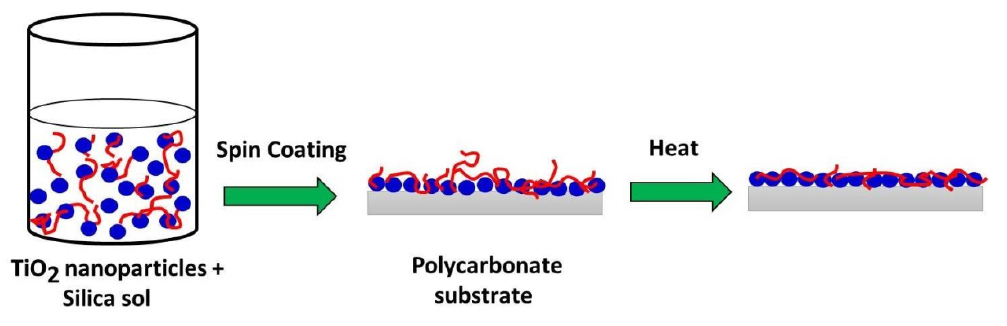
Figure 10. Schematic showing coating preparation